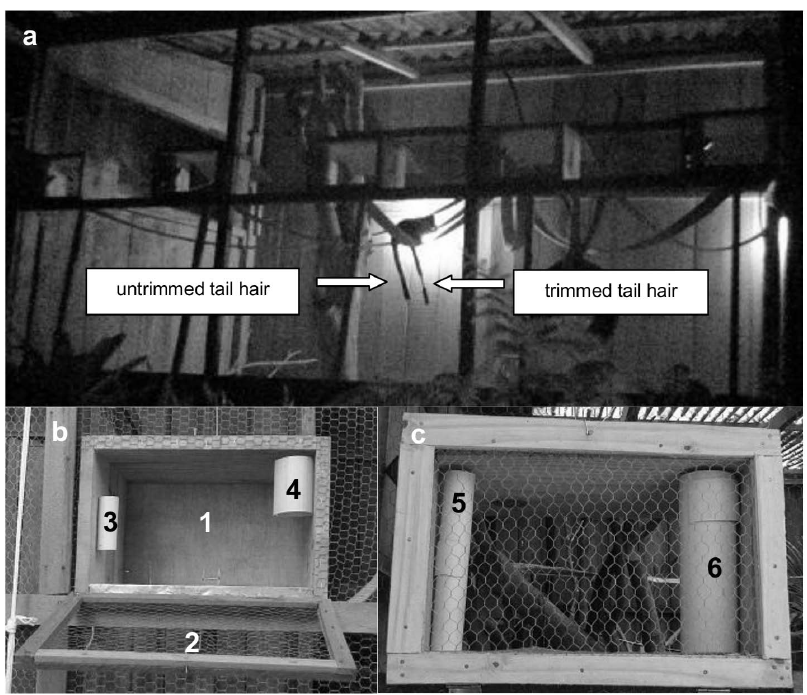
Fig. 1. Experimental setting. (a) Enclosure inhabited by group 4 (note the tail hair trimming in female F4 and the untrimmed tail hair of male M4); (b) feeding box with closed inner door (1), outer door open (2), support where the smell-tube was attached (3) and the support where the food-tube was attached (4); (c) feeding box with the outer door closed and the inner one open and with the smell-tube (5) and the food-tube (6)